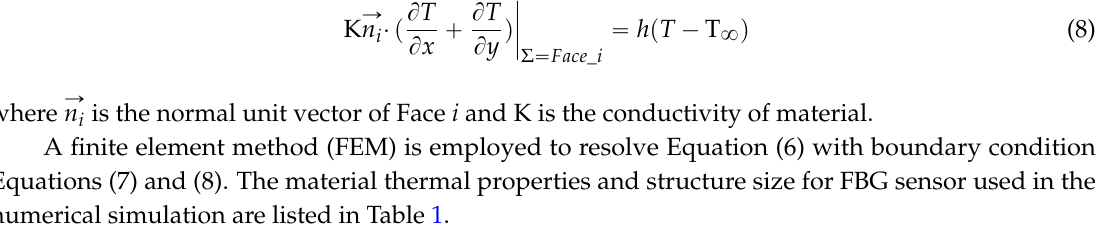
Table 1. Parameters in the numerical